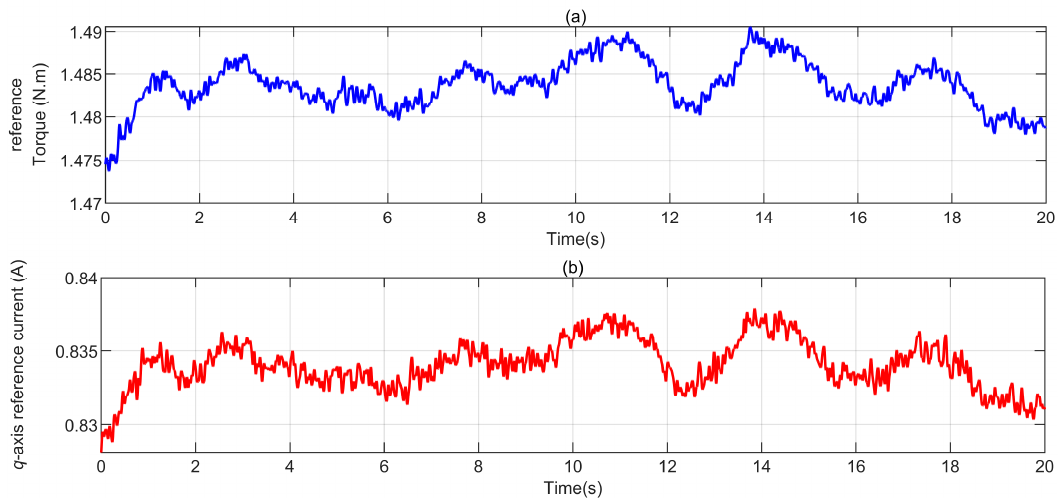
Figure 6. The experiment result: ( a ) machine speed; ( b ) reference torque; ( c ) d-axis reference current